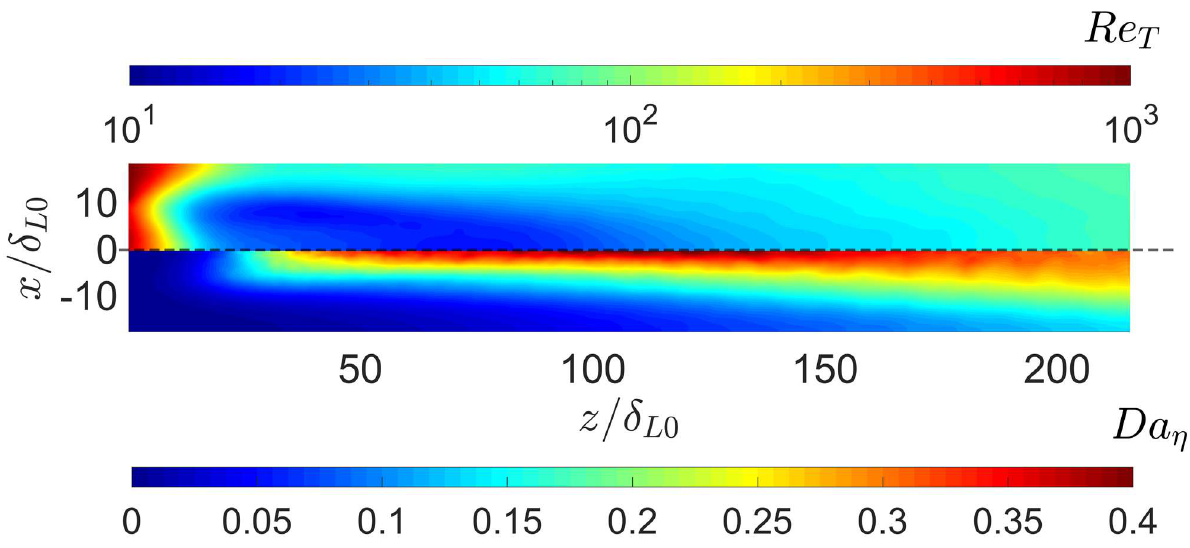
Figure 7. Relevant dimensionless numbers at the simulated flame: local turbulent Reynolds number (top), local Damköhler number of the Kolmogorov eddies (bottom). To investigate the dependency law 𝐶 (cid:3099) ~1/(cid:3435)𝐷𝑎 (cid:3086) (cid:3493)𝑅𝑒 (cid:3021) + 1(cid:3439) in greater detail, the error sensitivity 𝐸 (cid:3004) is plotted against this factor in Figure 8. Although the dispersion of the (cid:3347)